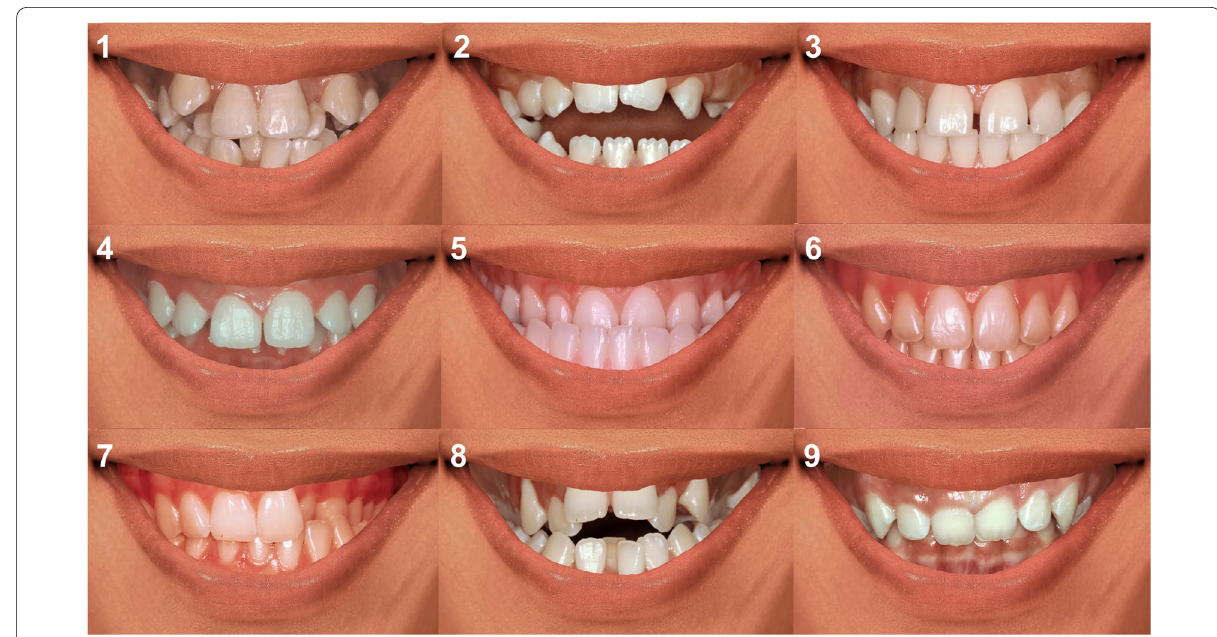
Fig. 1 Oral conditions presented in questionnaires. C1—crowding, C2—anterior open bite, C3—interincisal diastema, C4—increased overjet and deep bite (Class II division 1), C5—anterior crossbite (Class III), C6—ideal occlusion, C7—unilateral posterior crossbite, C8—anterior open bite plus bilateral posterior crossbite plus crowding, and C9—deep bite (Class II division 2)